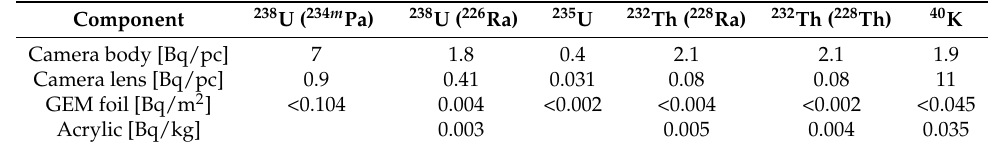
Table 1. Measured activity of the internal detector components expected to produce the largest backgrounds in the active volume. The isotopes in parentheses indicate the activity from that particular part of the decay chain. Upper limits are given at the 90% confidence